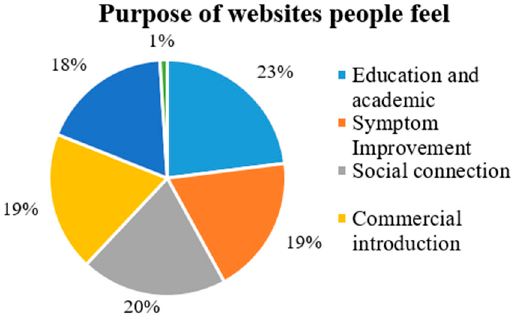
Table 6. Estimated percentages of websites in compliance with the criterion of content design.